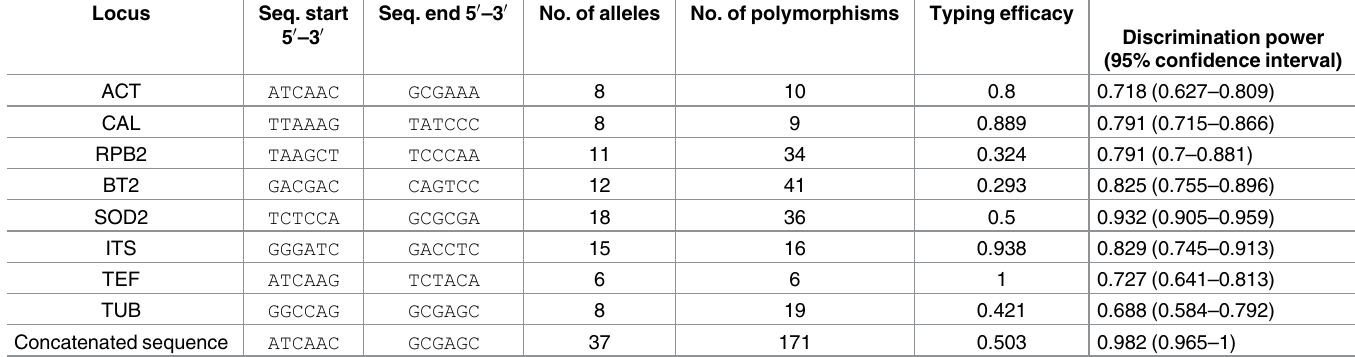
Table 3. Starting and ending sequences, number of alleles, number of polymorphisms, typing efficacy, and discrimination power of each